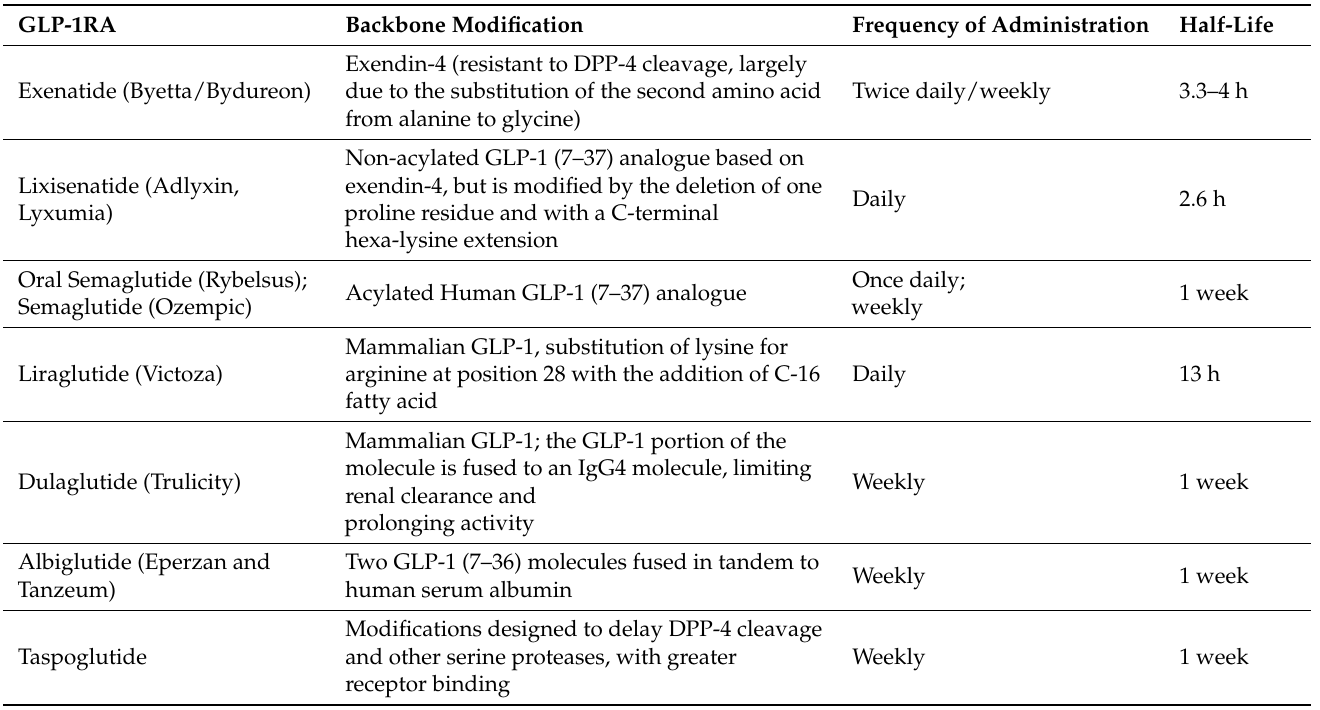
Figure 2. Indirect effect of GLP-1 receptor agonists (GLP-1RAs). Activation of central GLP-1 receptor signalling in the brain leads to metabolic reprogramming in the peripheral tissues. Shown are the effects on blood glucose homeostasis, lipid metabolism and gastrointestinal motility. Table 1. GLP-1RAs: backbone modifications, frequency of administration and